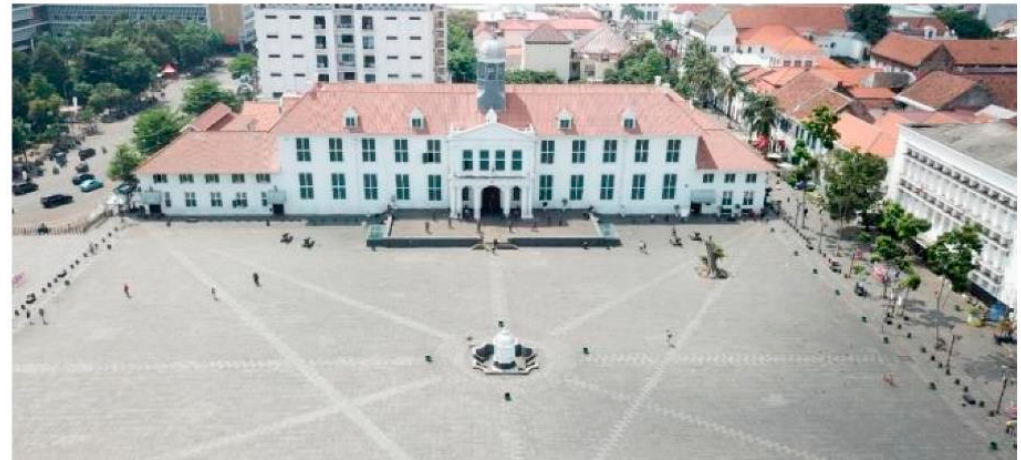
Figure 17. Jakarta History Museum and Fatahillah Square in 2017.